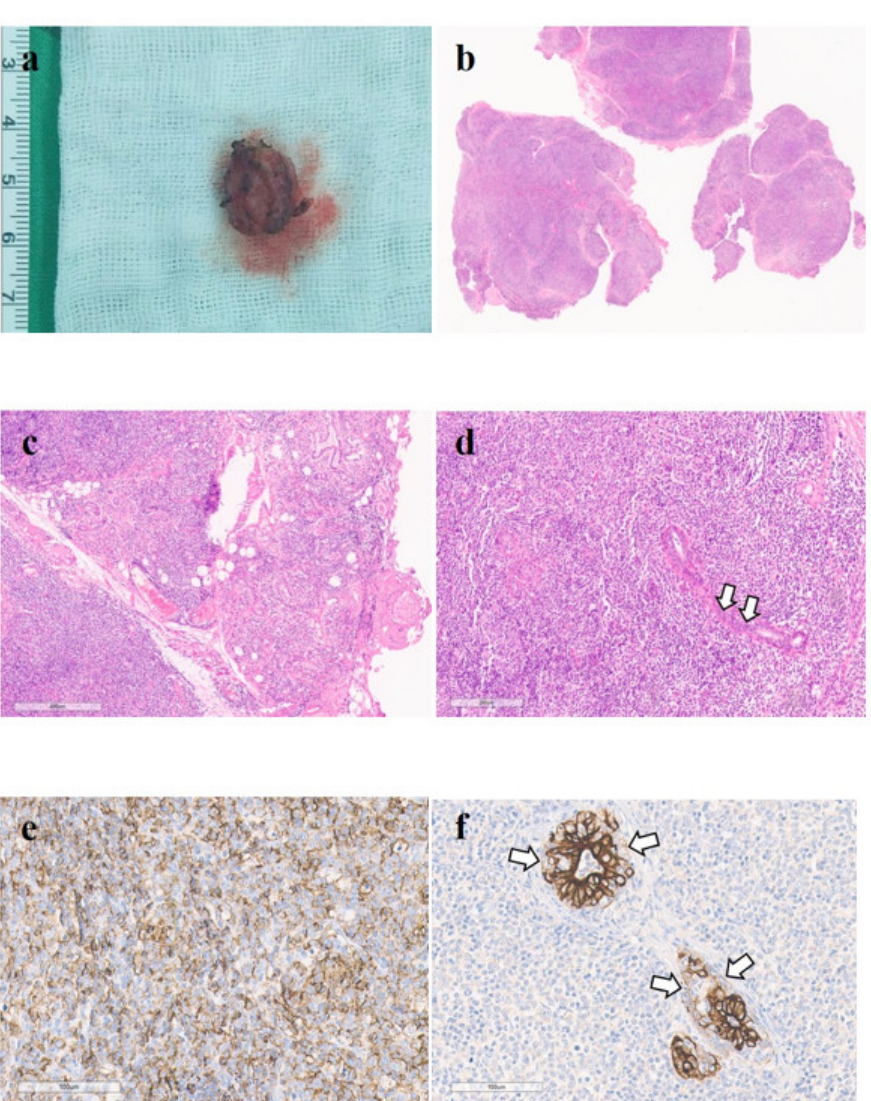
Figure 4. ( a ) A photograph of the specimen shows the excised nodule (2.5 cm in size). ( b ) Extensive lymphocytic infiltration of the minor salivary gland is noted. There are multiple lymphoid follicles with germinal centers (hematoxylin and eosin, ×10). ( c ) In the periphery, minor salivary glandular tissue with residual intercalated ducts appears fibrotic and infiltrated by numerous lymphoid cells. Seromucinous units or mucous acini of the minor salivary glands are hardly seen (×80 hematoxylin and eosin). ( d ) On higher magnification, the lymphoid infiltration appears to be intense, and mo- notonous atypical lymphoid cells are visible as well. Lymphoepithelial lesions (arrows) were visible, and mucosa-associated lymphoid tissue (MALT) lymphoma was suspected (×100, hematoxylin and eosin). ( e ) These monotonous atypical-looking lymphoid cells were diffusely positive for CD20. B-cell phenotype lymphoma was suspected (CD20, × 200). ( f ) Salivary gland ductal cell infiltration by cytokeratin-negative atypical-looking lymphoid cells indicates the presence of a lymphoepithelial lesion. Extranodal marginal zone B-cell lymphoma of MALT is highly suspected (cytokeratin, ×